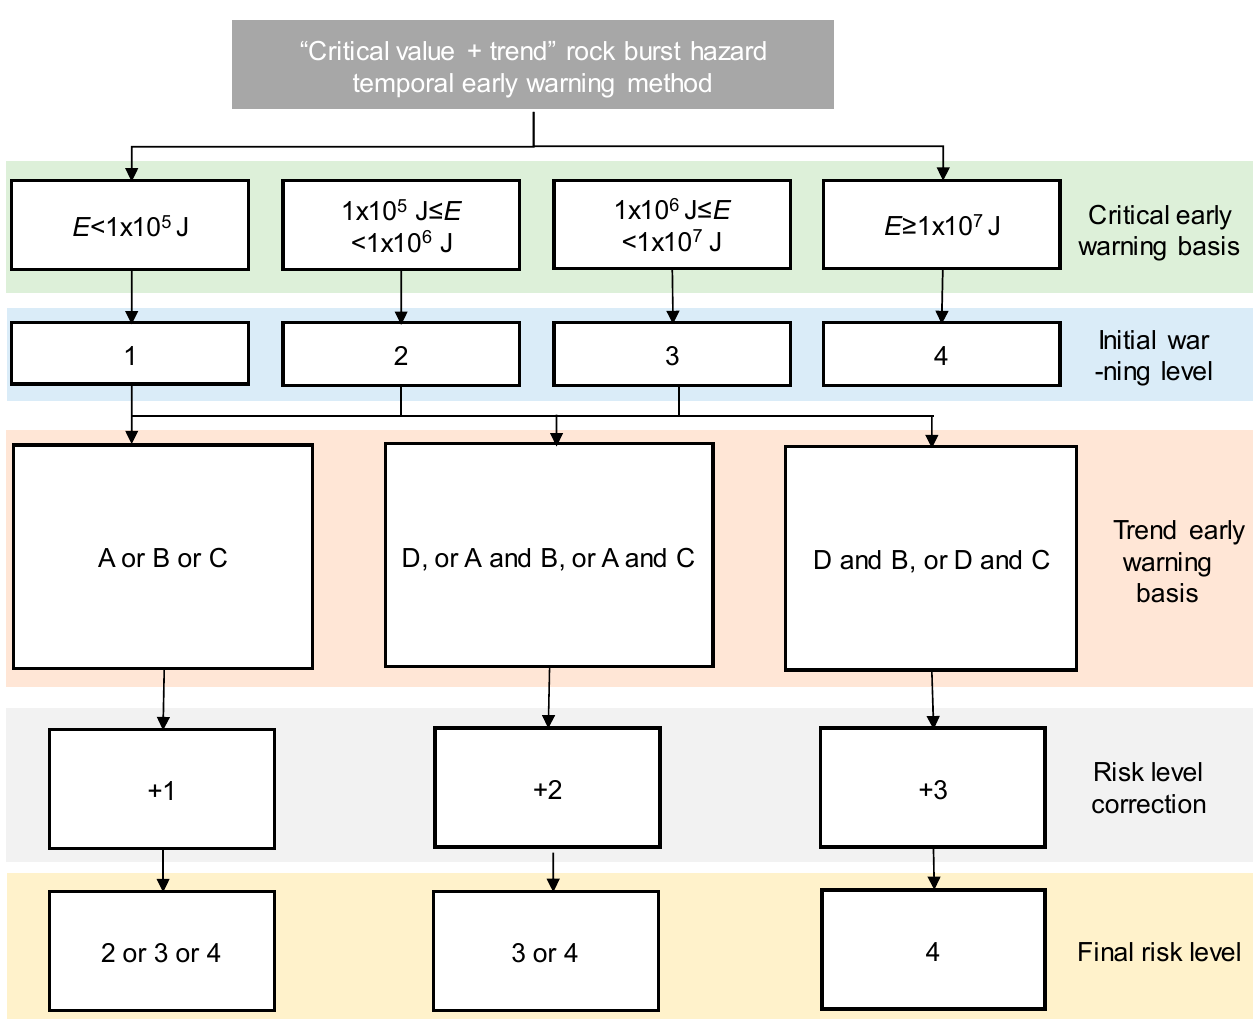
Figure 11. “Critical value+ trend” rockburst temporal early warning method. E : maximum energy.